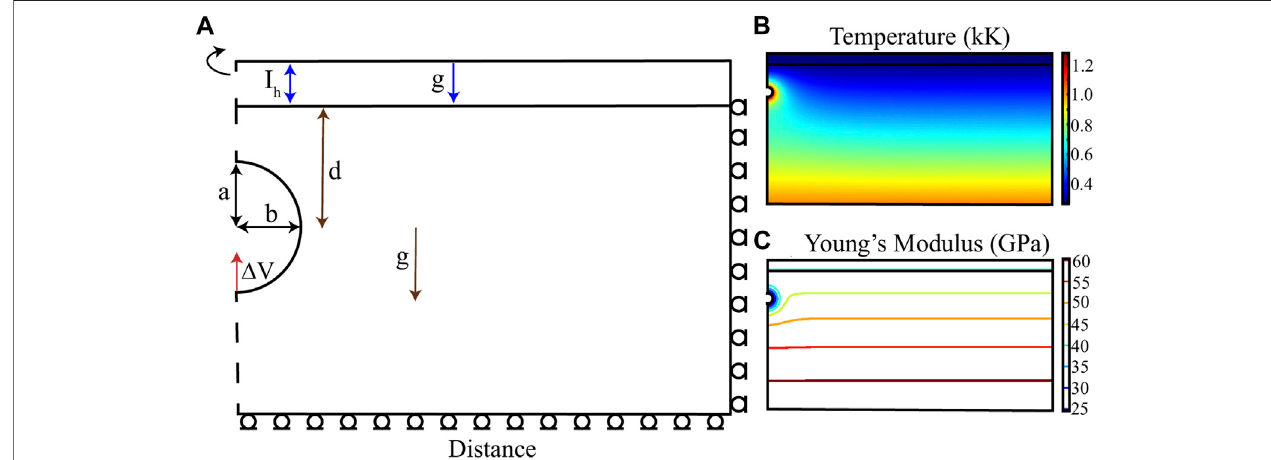
FIGURE2| Finiteelementmodelsetup. (A) Schematicdiagramofmodelgeometryandboundaryconditions.Theleftboundaryhasrotationalsymmetrywhileroller conditions are implemented along the bottom and top boundaries. The model space is divided into a variable-thickness layer of ice on top of a 50 by 25 km domain representing the magmatic system host rock. The magma chamber is simulated as a pressurized elliptical void along the rotational boundary, while the labels indicate different parameter values used in this study and the gravitational loading incorporated into both model domains. Depth to center is indicated by “ d ” ; however, some experiments use the depth to the crest of the magma chamber as indicated in the text. (B) Heat transfer module is incorporated in the model, and rock near the magma chamber (1,000 ° C) experiences higher temperatures. Temperature gradient of the Earth is also represented in the models as 30 ° C/km. (C) Temperature- dependent Young ’ s Modulus is de fi ned in the models to make them viscoelastic, therefore temperature- and time-dependent.